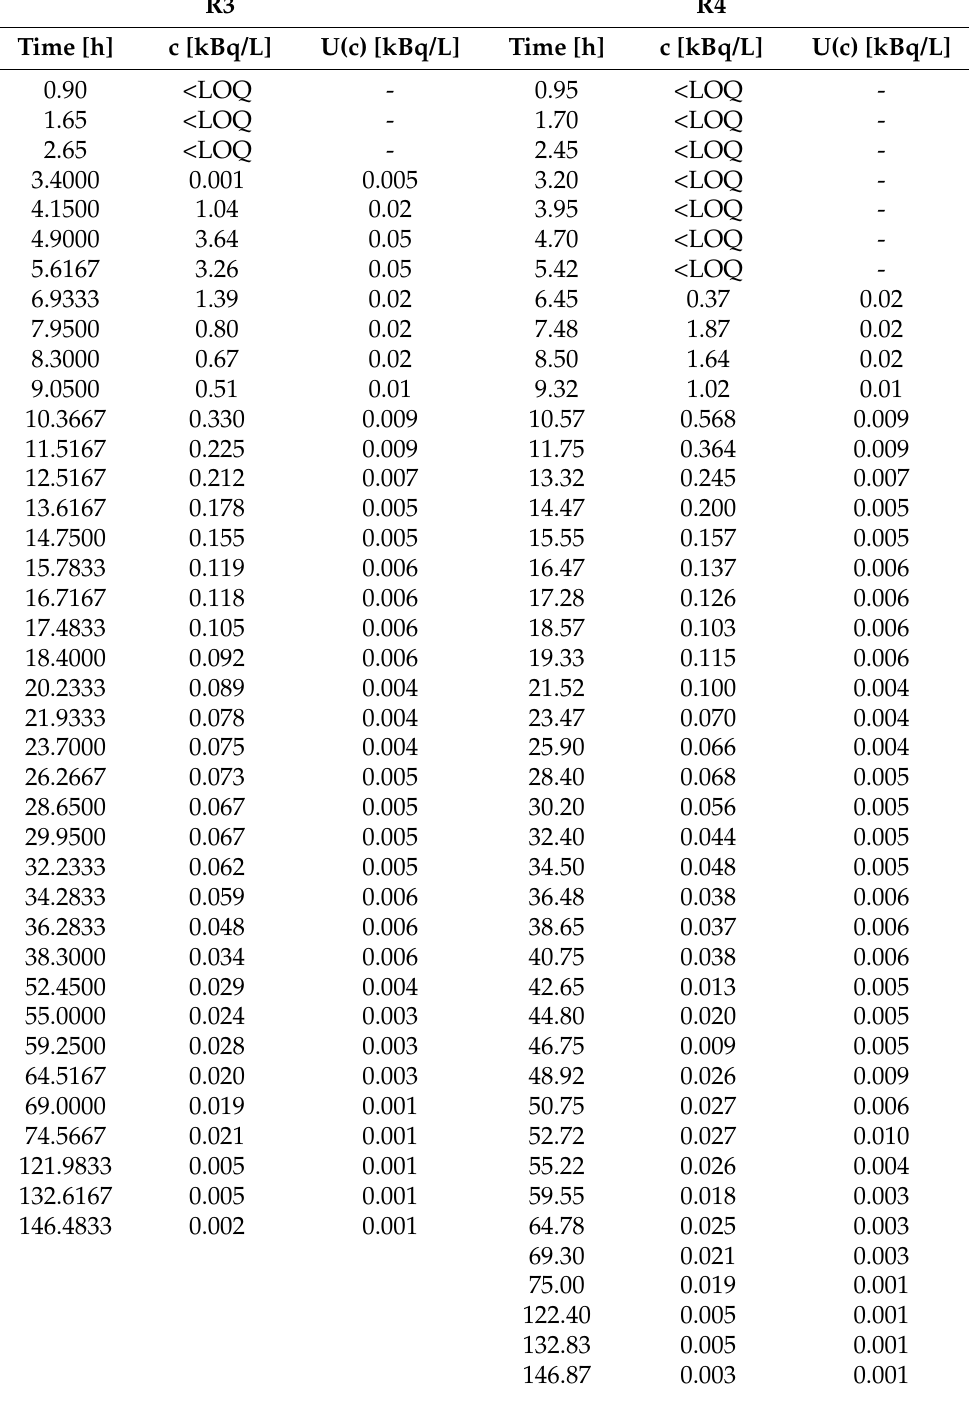
Table A6. In-stream 32 P activity concentrations and their analytical uncertainties at points R3 and